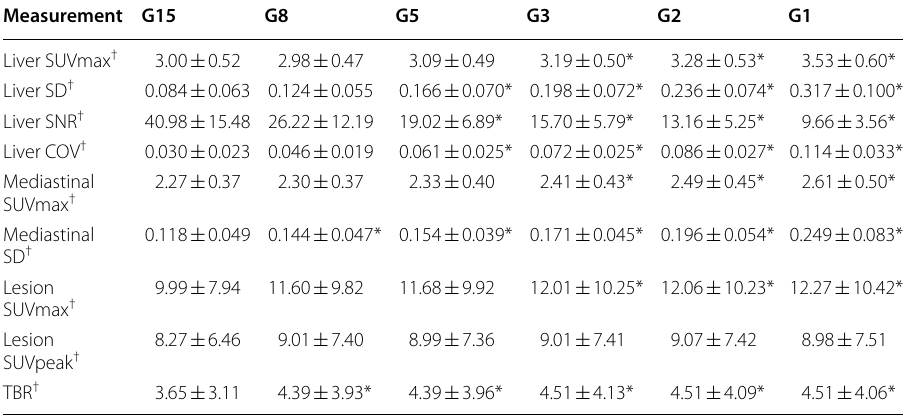
The measured sample sizes for the background and lesion were 46 and 56, respectively SUVmax maximum standardized uptake value; SD standard deviation; SNR signal‑to‑noise ratio; COV coefficient of variation; SUVpeak peak standardized uptake value; TBR tumor‑to‑background ratio. † Data are presented as mean standard deviation (mean SD) ± ± *Significant difference in comparison with the control group (G15), p < 0.05